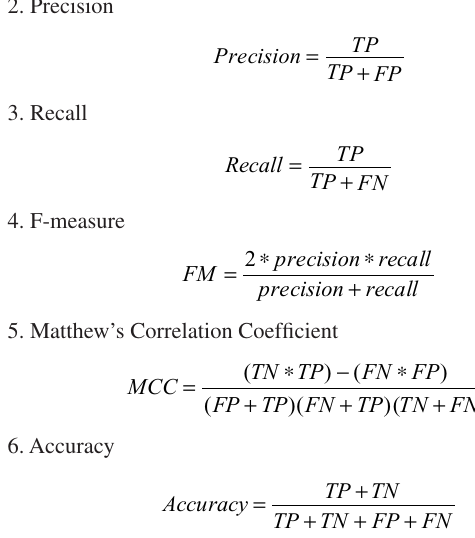
Figure 1 represents the comparison of accuracy rates among the selected machine learning algorithms in predicting women’s depression and anxiety symptoms. All tested models reported a high level of accuracy (ranging from 80.0–83.3%) for pre- dicting depression among pregnant women except for NB.